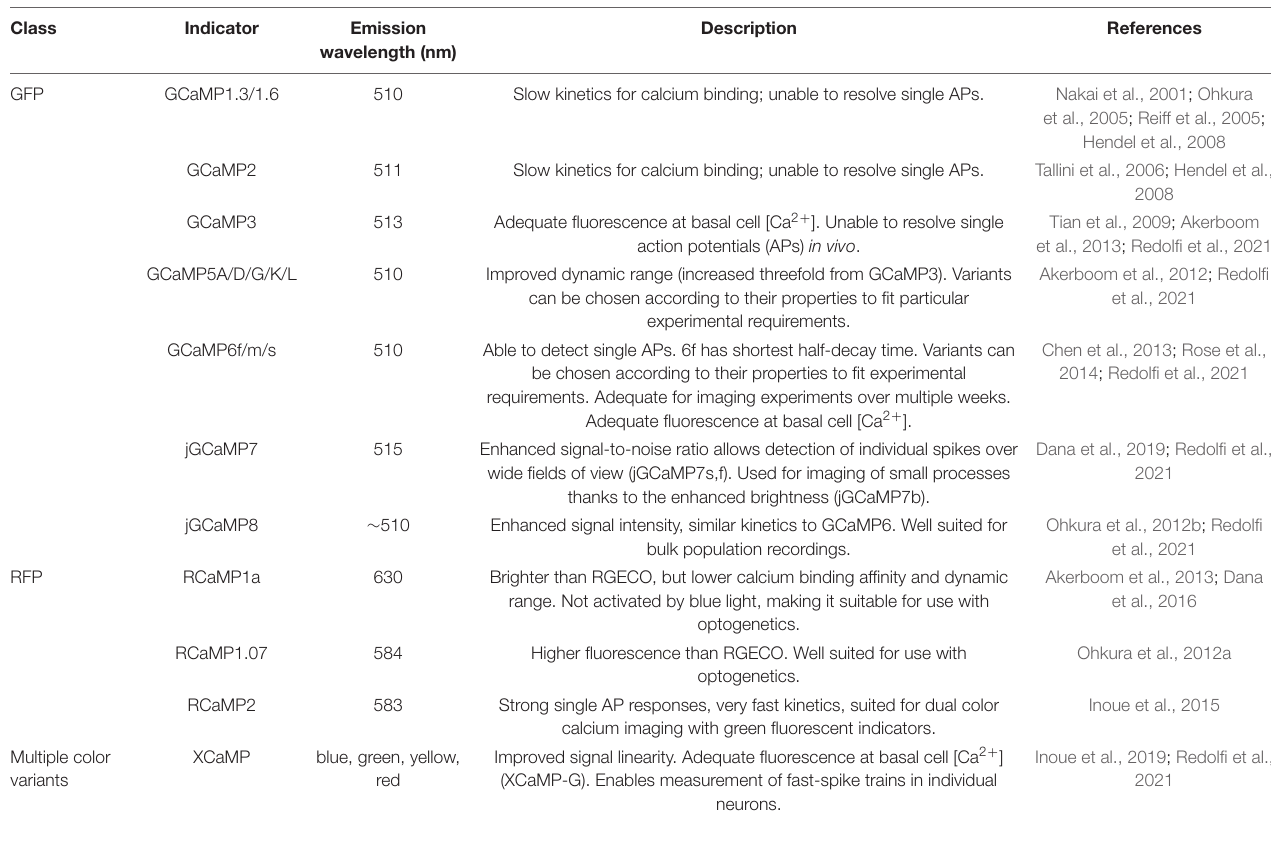
TABLE 2 | Commonly used GCaMP